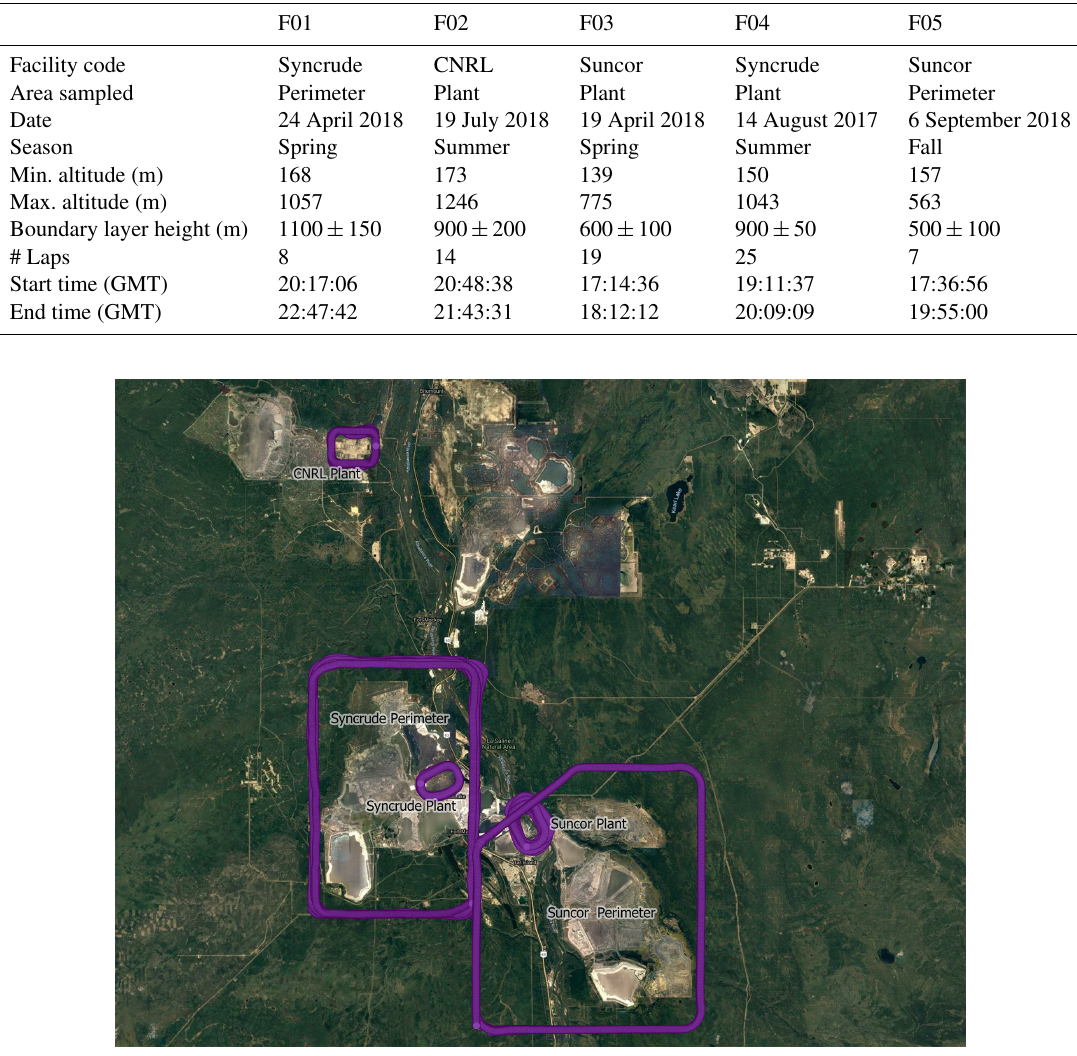
Figure 1. The flight paths (one second intervals) are shown for each facility sample used in the study. Perimeter flights are the large polygons, and plant flights the smaller ovals. Map layer data ©Google Satellite Hybrid